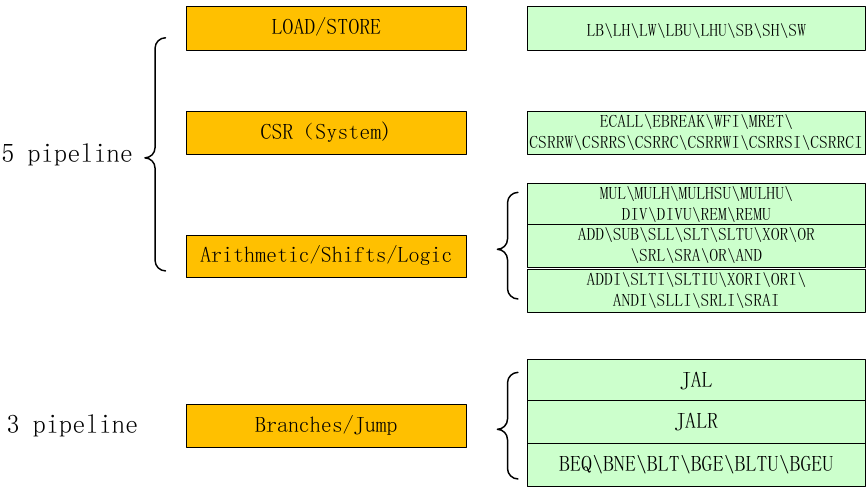
Figure 13. Rv32IM instruction classification.